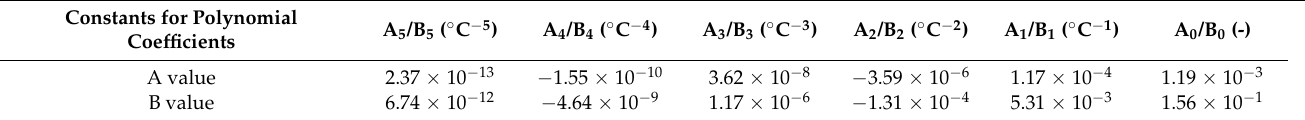
Table 1. Constants defining the effectiveness factor (f = 1 Hz).